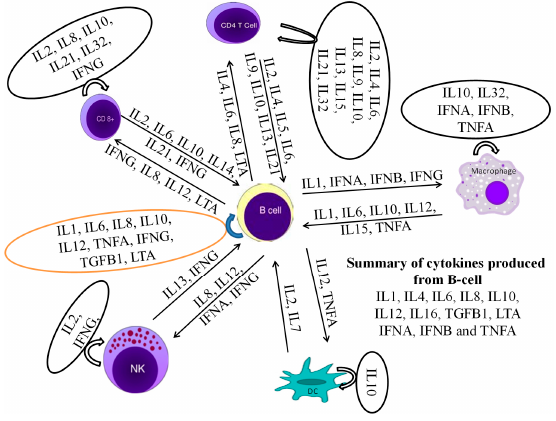
Figure 9. Flow sheet diagram of samples collected from various cells types and the calibrators for cytokine production analysis. Genes 2019 , 10 , 329